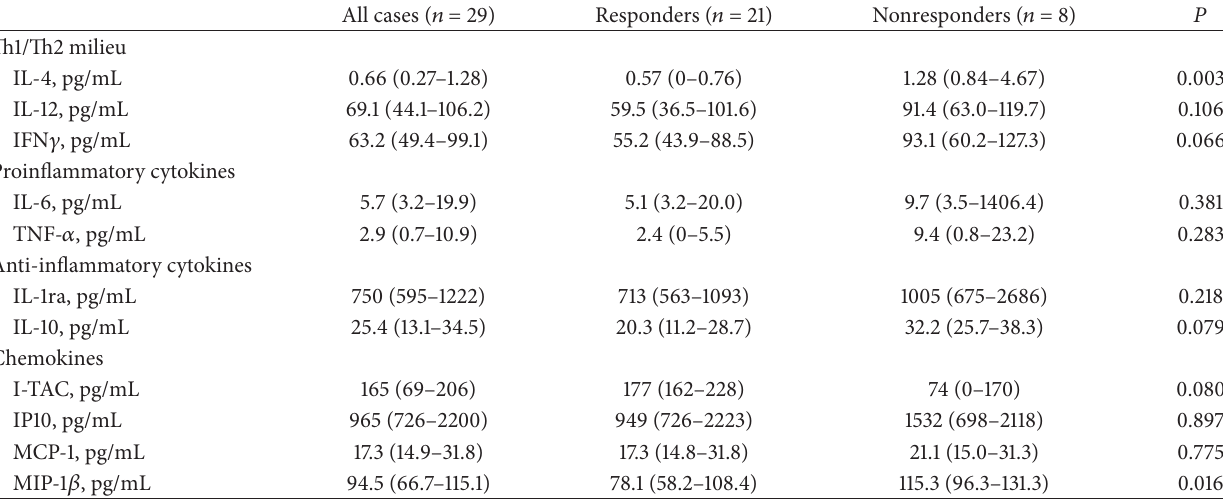
Table 2: Inflammatory pattern at 24 hours from daily administration of dual antiplatelet treatment in clopidogrel responders and